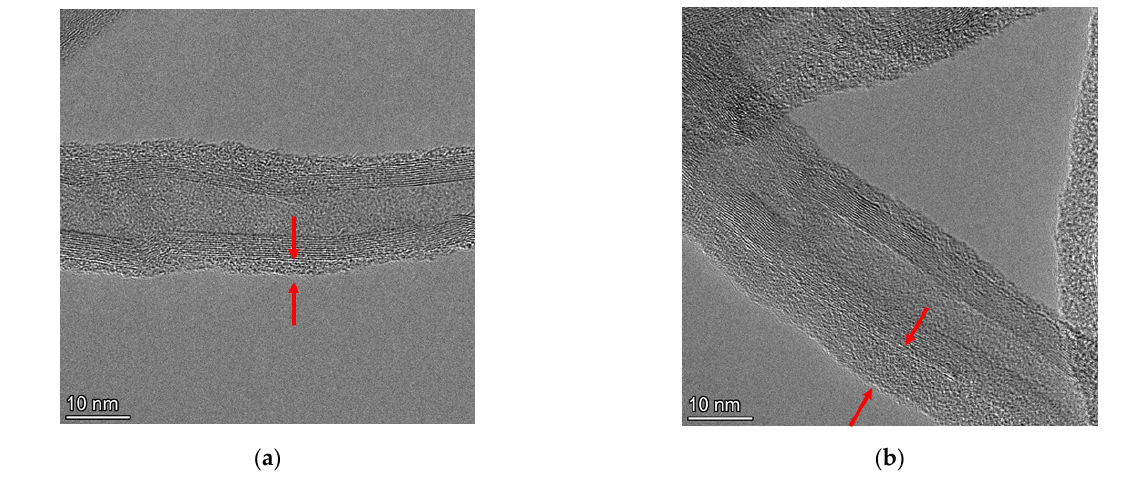
Figure 2. TEM of ( a ) MWCNTs-PDA and ( b ) MWCNTs-PDA-PDMAEMA.